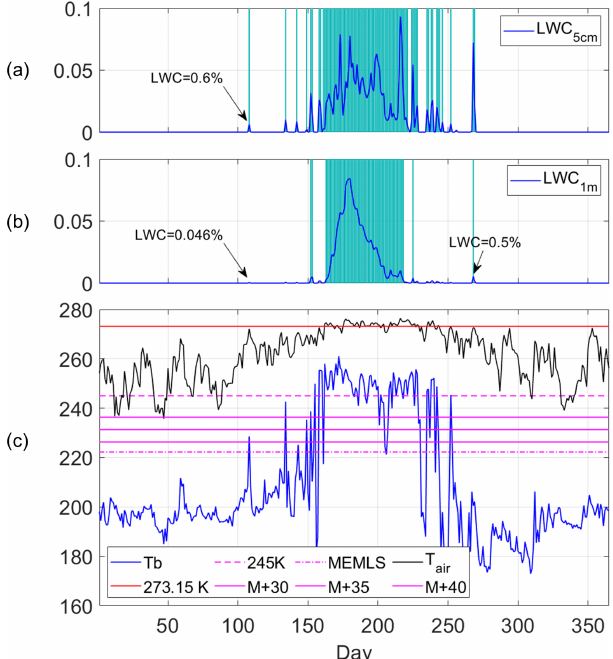
Figure 7. LWC from MAR averaged in the first 5cm (a) and the first 1m (b) of the snowpack. (c) Time series of the 37GHz horizontally polarized T b (3.125km, blue), air temperature from AWS (black) and 245K (dashed magenta line), M + (cid:49)T (solid magenta lines) and MEMLS (dot-dashed magenta line) thresholds for the Swiss Camp site in the year 2001. Melting days according to MAR are marked as vertical light blue lines in panels (a) and (b)